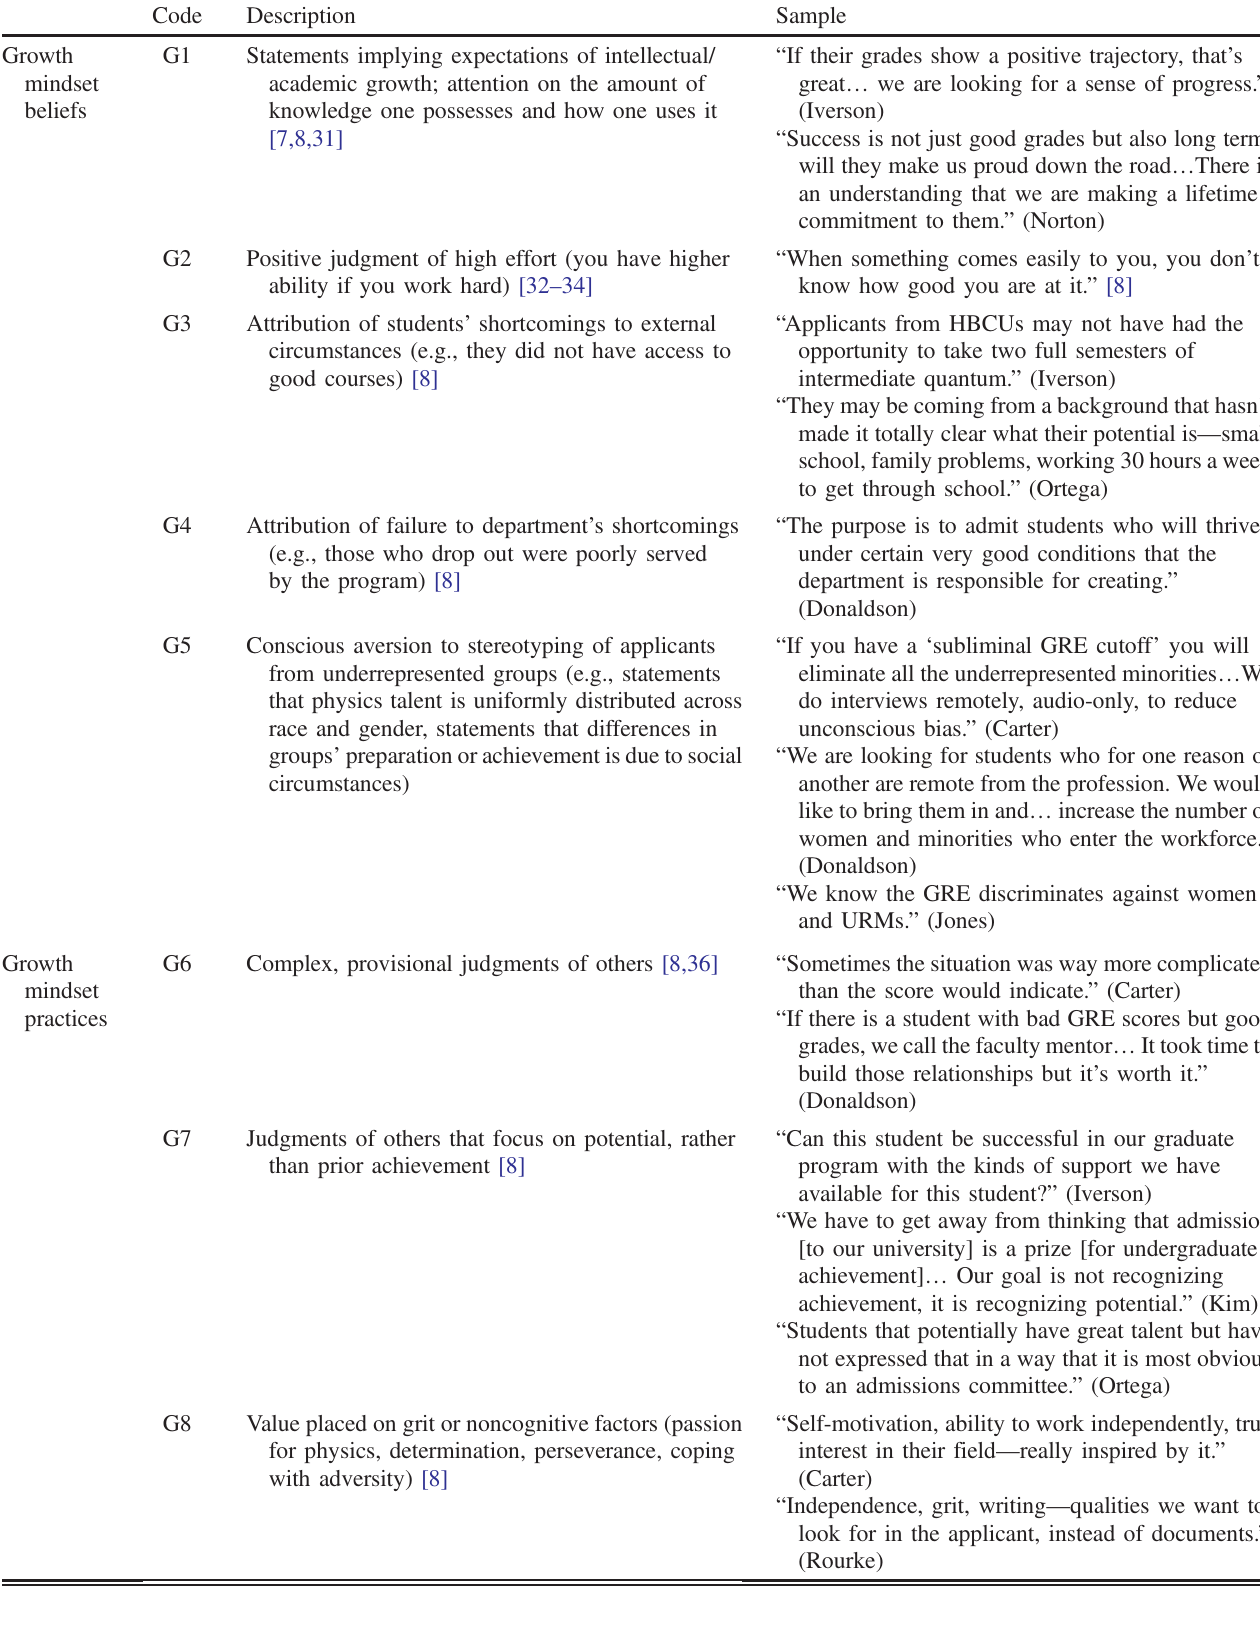
TABLE II. Coding scheme for growth mindset (G1-G8), with sample text from interviews to illustrate each code. Codes G1-G5 refer to beliefs or attitudes associated with the growth mindset; codes G6-G8 refer to practices associated with that mindset. Names are pseudonyms of individual